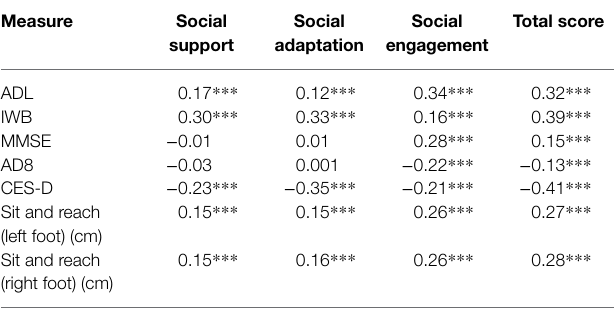
TABLE 5 | Correlations coefficients between social function and criterion variables ( n =